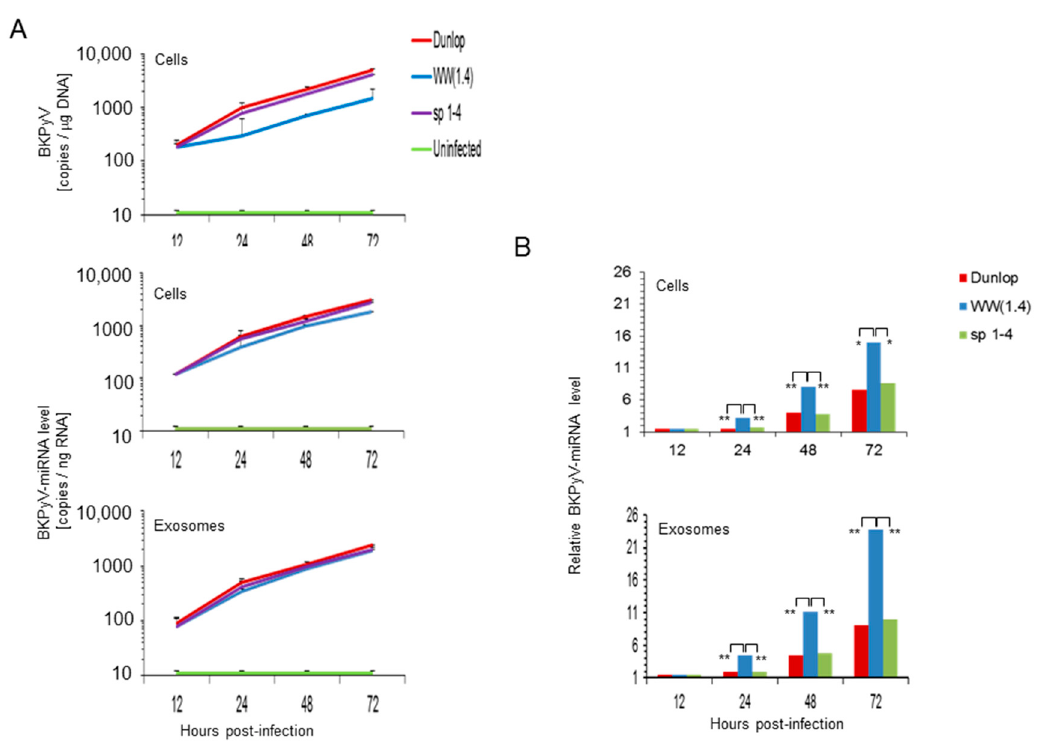
Figure 4. RPTECs infected with BKPyV variants having increased EVGR activity are associated with lower miRNA levels than archetype BKPyV . ( A ) Time course of BKPyV DNA replication and miRNA-5p expression in RPTECs and corresponding exosome- preparations. RPTECs were infected and viral DNA genome and BKPyV -miRNA-5p expression were measured at 12, 24, 48 and 72 h post infection as detailed in Materials & Methods. BKPyV genome load was expressed per total µg DNA; miRNA was quantified per total ng RNA (mean ± standard deviation of 3 independent experiments). ( B ) Comparison of relative miRNA expression levels per BKPyV genome copy (template) in cells. Results are expressed as BKPyV -miRNA levels normalized to BKPyV genome copy number, archetype WW ( 1.4 ) values at 12 h post-infection are set to 1 (-fold; * p < 0.05; ** p < 0.01).